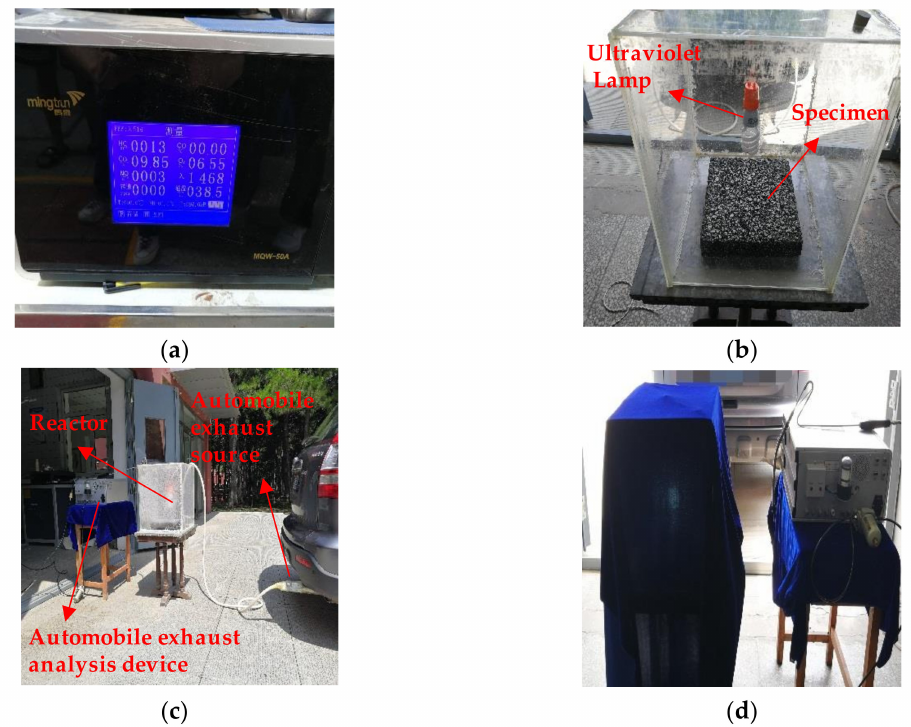
Figure 4. The apparatus of photocatalytic degradation experiment: ( a ) automobile exhaust analysis device; ( b ) reactor; ( c ) test device; ( d ) test